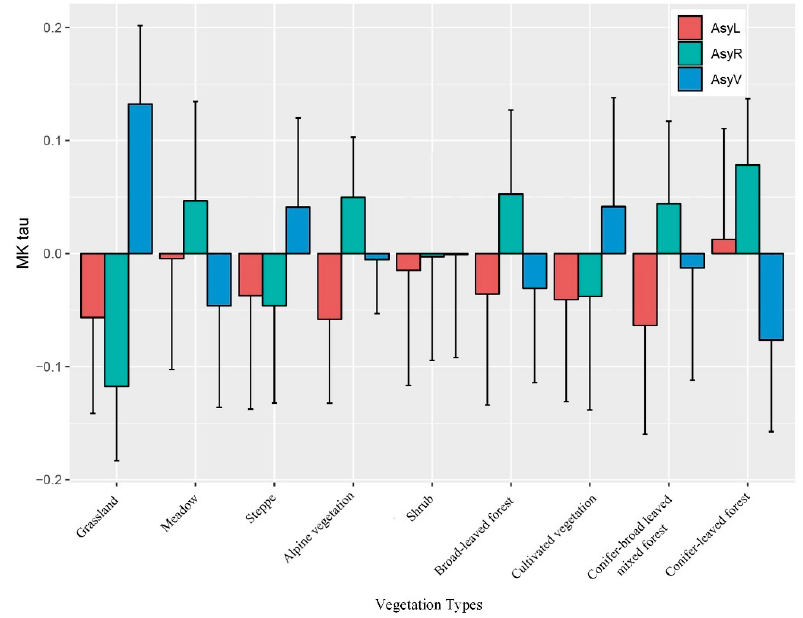
Figure 6. Statistics of asymmetry trends for various vegetation cover areas (averaged value + one standard deviation).